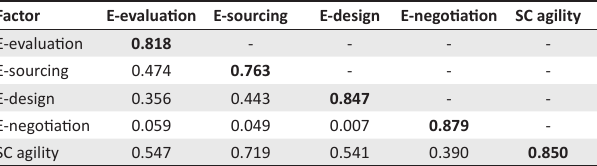
SC, supply chain.